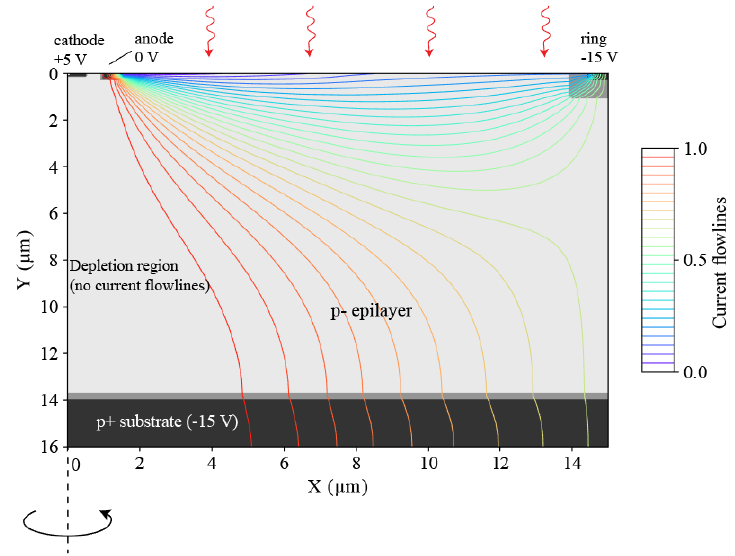
Figure 3. Cross section of the example structure to demonstrate current-assistance principle with an overlay of simulated current flowlines.